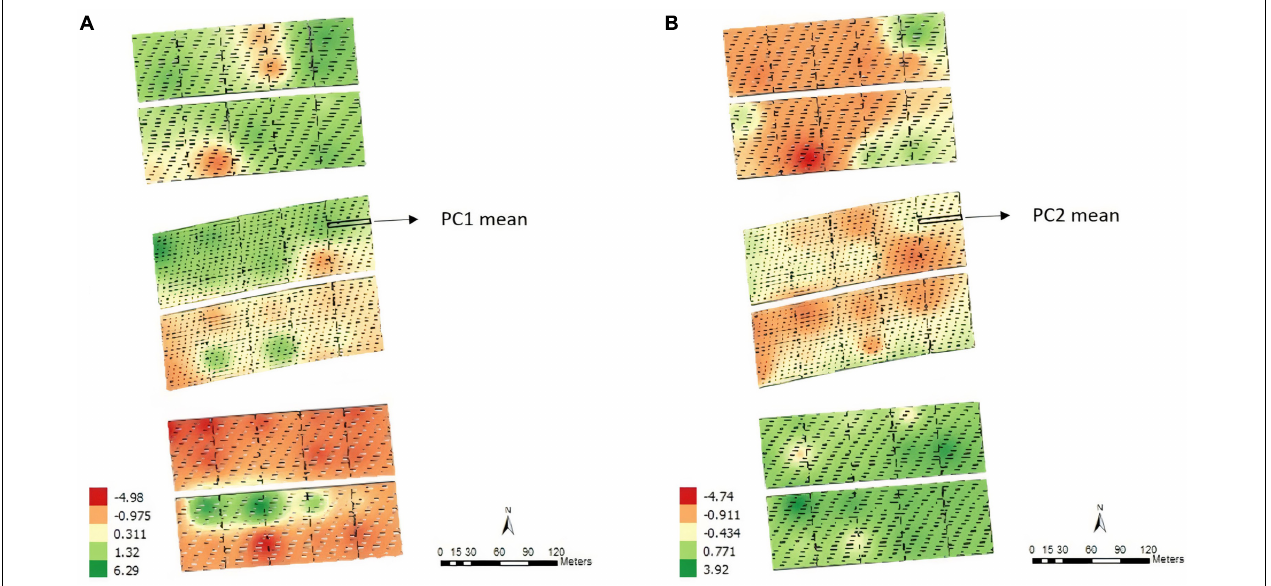
FIGURE 1 | Thematic map generated by inverse distance weighting (IDW) and overlap of the experimental plots on the interpolated map and the average values of the points of interest for principal component 1 – PC1 (A) and principal component 2 – PC2 (B) , Experimental Area 1.